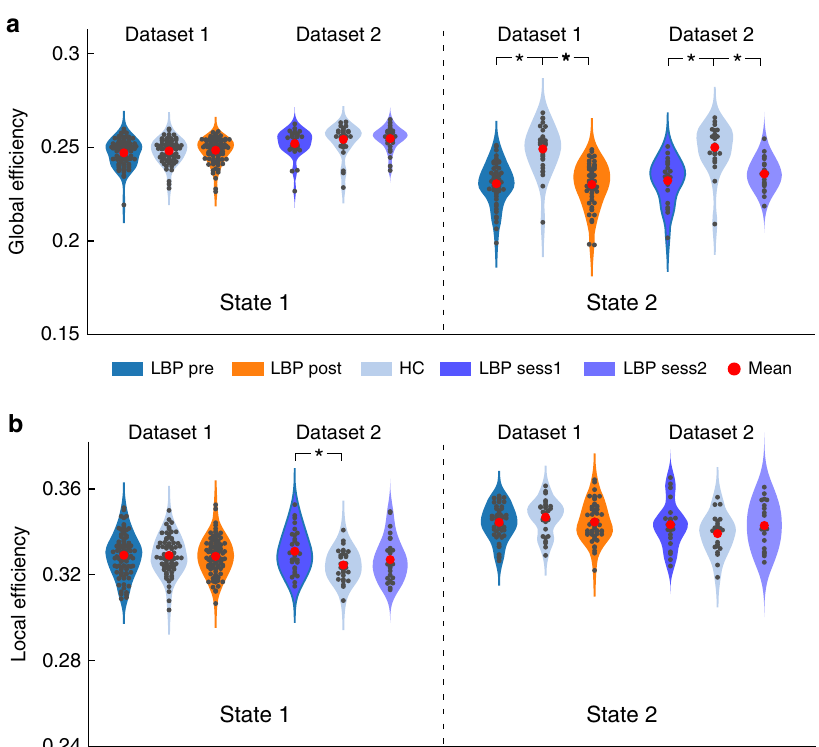
Fig. 4 Topologic measures of dFNC states. Global ( a ) and local ef fi ciencies ( b ) in the two different states are shown using violin plots for different groups (pre-maneuver, post-maneuver, and HCs in Dataset 1, N = 90 and 74 for cLBP patients and HCs, respectively; LBP session 1, session 2, and HCs in Dataset 2, N = 30 and 30 for cLBP patients and HCs, respectively). Each dark dot represents an individual ’ s value and each red dot indicates the group mean. Asterisks represent signi fi cant difference at two-sided p FDR < 0.05 for t -test. Source data are provided as a Source Data fi